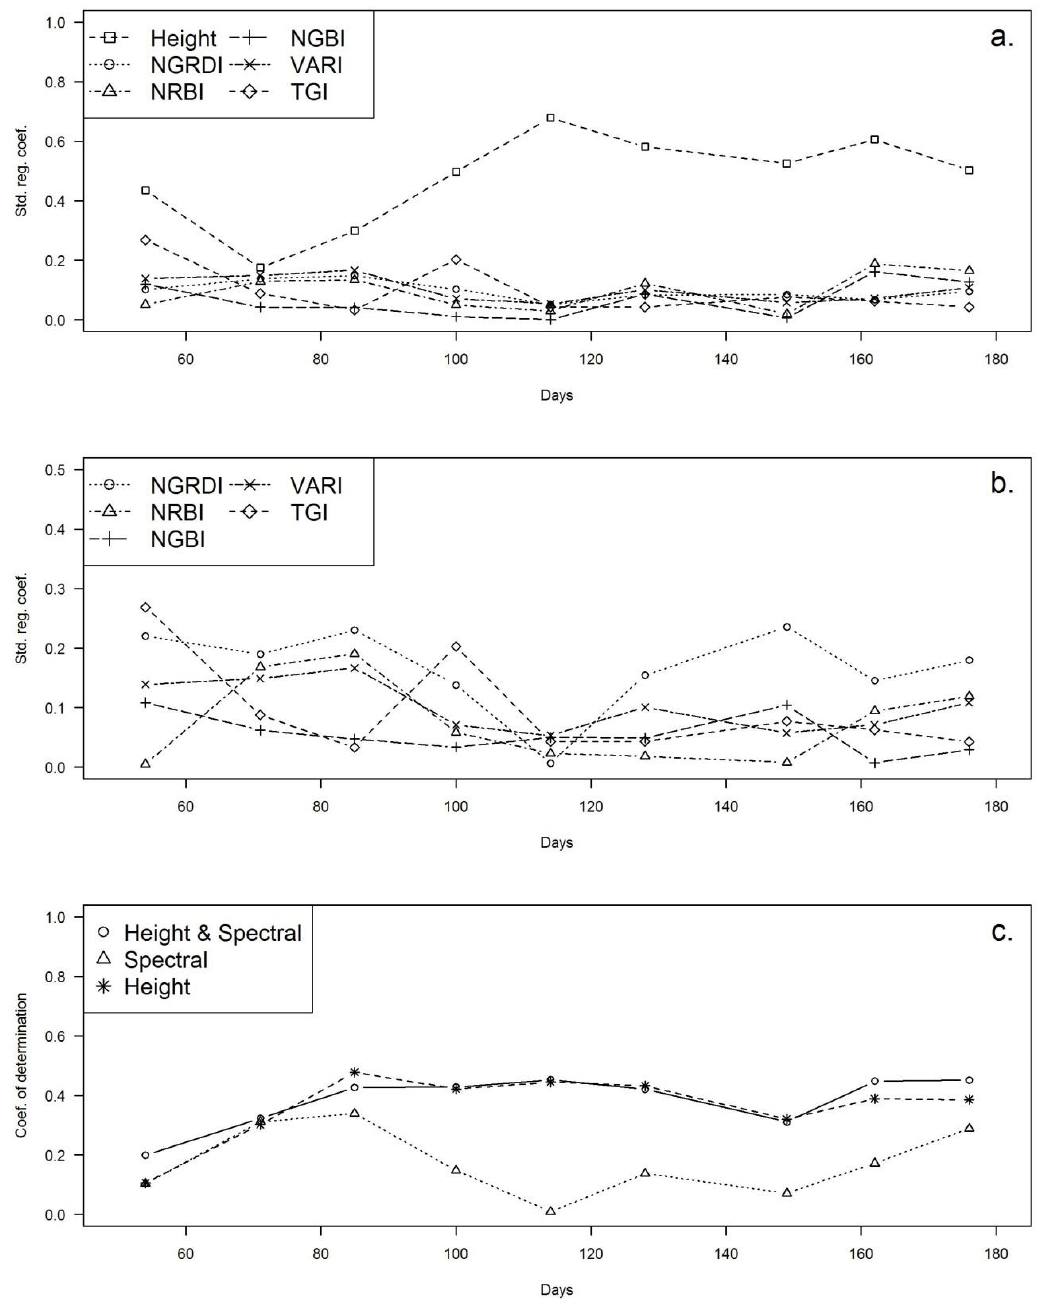
Figure 3. Added value of height data to predict the final AGB in maize crop. The origin of the X axis corresponds to the sowing of the maize crops. Subplot ( a ) shows the relative contribution of each variable in the “Mixed” final AGB model (1a). Subplot ( b ) presents the relative contribution of each variable in the “Spectral only” final AGB model (1b). Subplot ( c ) displays the temporal evolution of the R-square associated with the “Mixed” AGB model (1a), the “Spectral only” AGB model (1b) and the “height only” AGB model (1c).